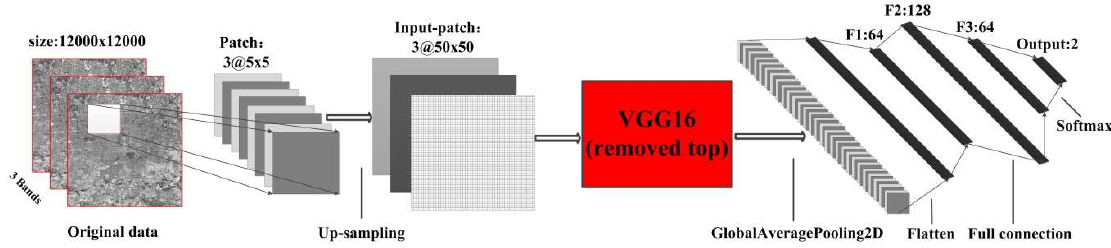
Figure 12. Transfer learning and fine-tuning of VGG16.